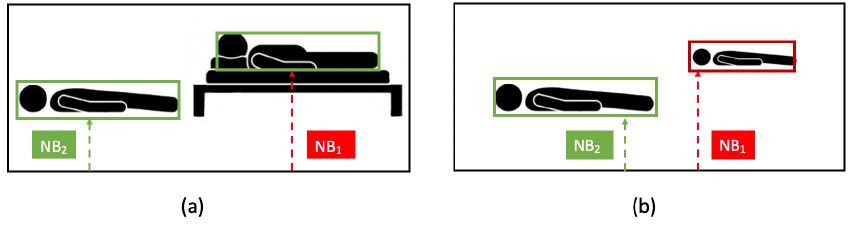
Figure 6. Relation between the NB i parameter and the bounding box size. ( a ) Fallen and resting persons at same distance from camera. ( b ) Two fallen persons at different distances from